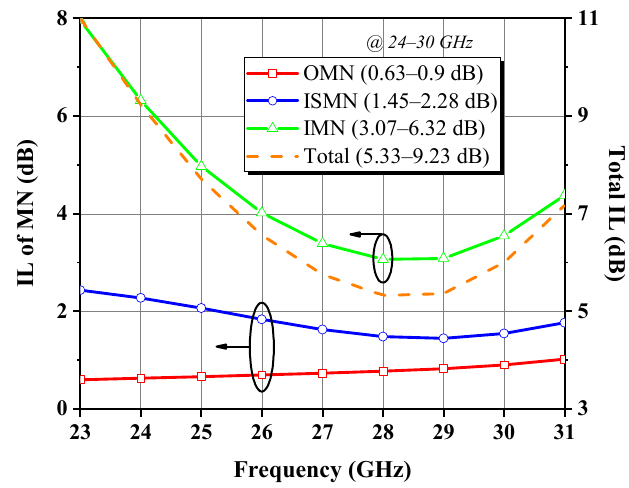
Figure 18. IL of each MN and all MNs as a function of frequency. Apart from the inherent dissipation loss of the MN, another is the mismatch loss, which together ensures the gain flatness of the DA. The total efficiency η tol of a lossy MN is defined as the ratio of the delivered power P L (i.e., P out_MN ) absorbed by load to the available power P avs from the source V g , expressed as